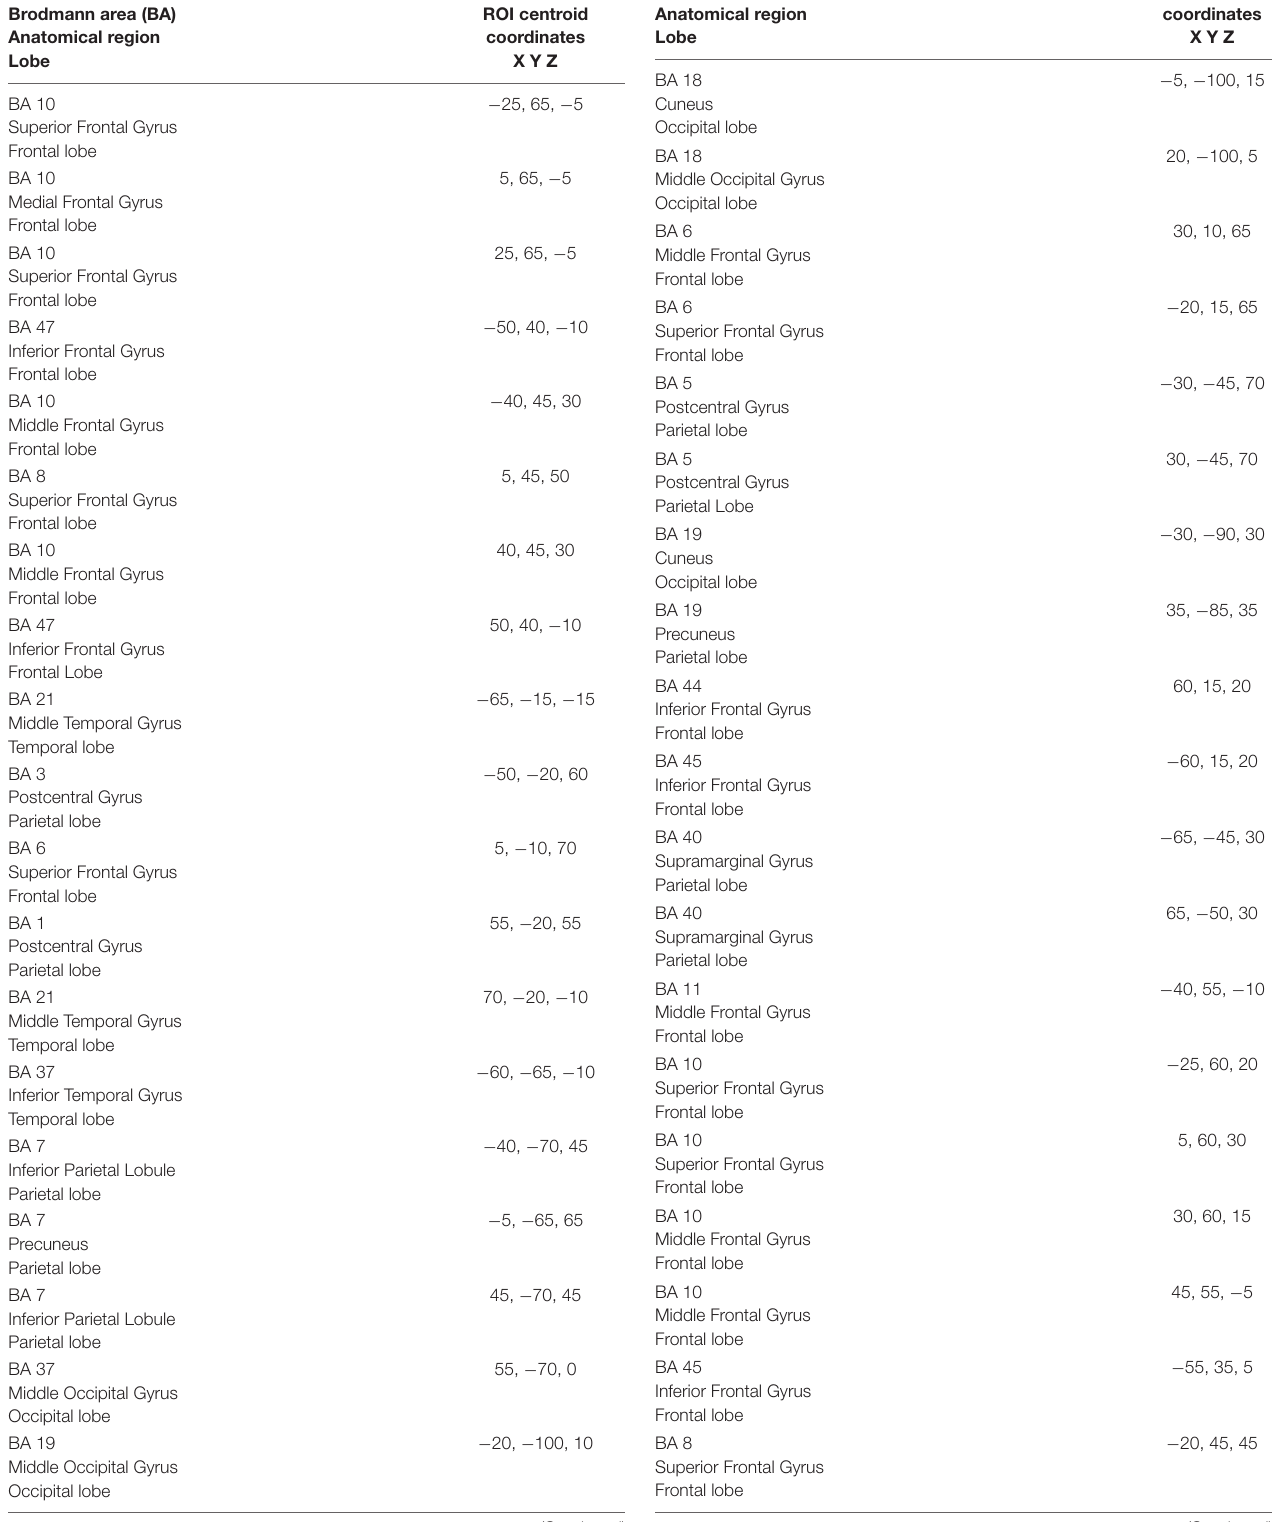
TABLE 2 | The 61 ROIs created in LORETA for the analysis of functional connectivity in terms of “lagged phase synchronization.” Brodmann area (BA) Anatomical region Lobe